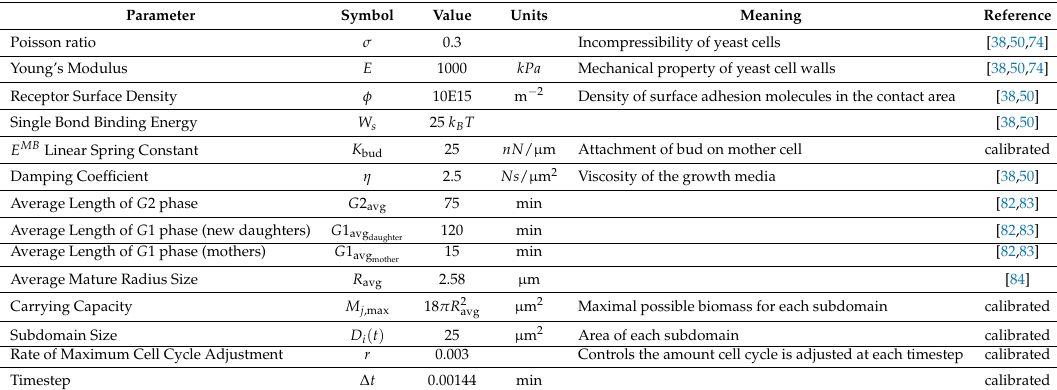
Table 1. Parameter Values Used in ABM. Descriptions of the biophysical and biological processes corresponding to these variables are detailed in Section